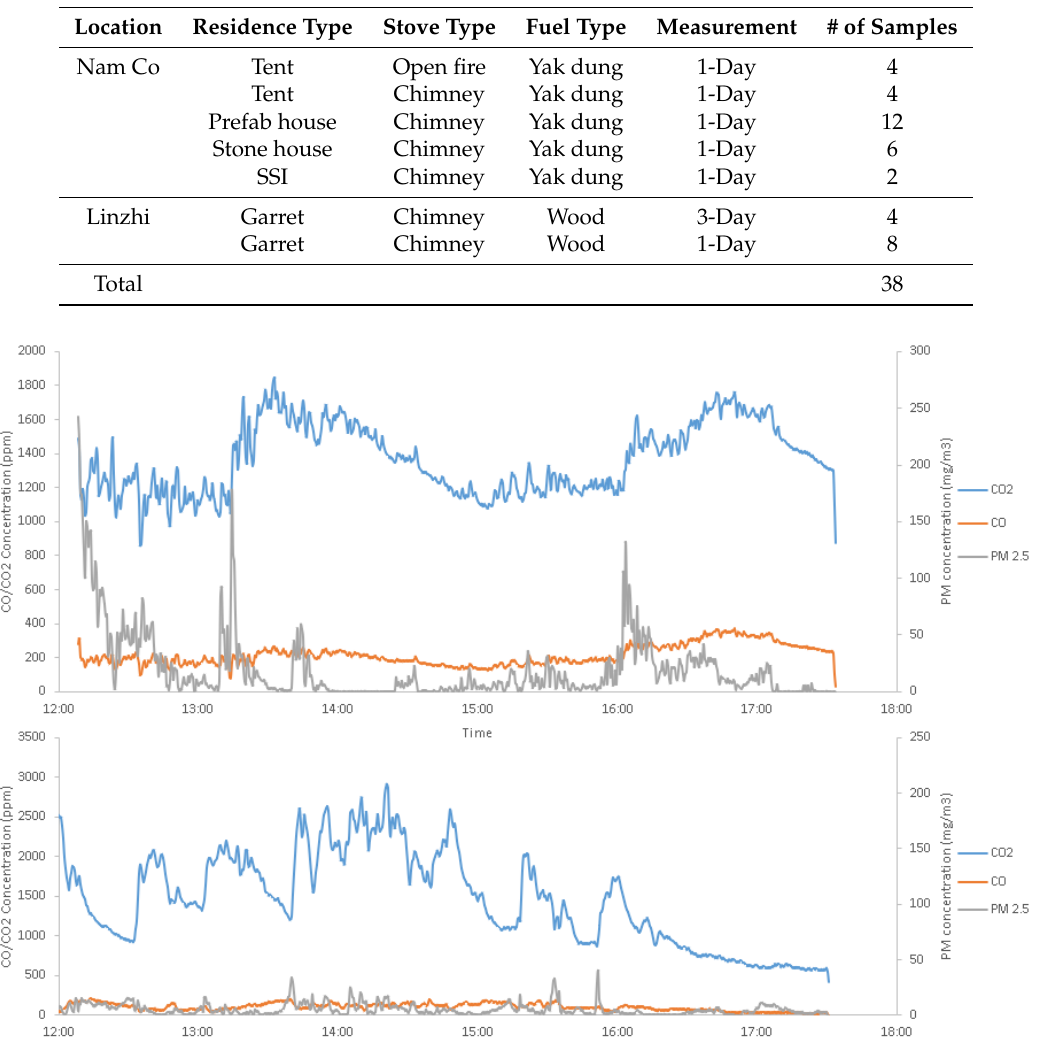
Table 1. Tibet household summary.